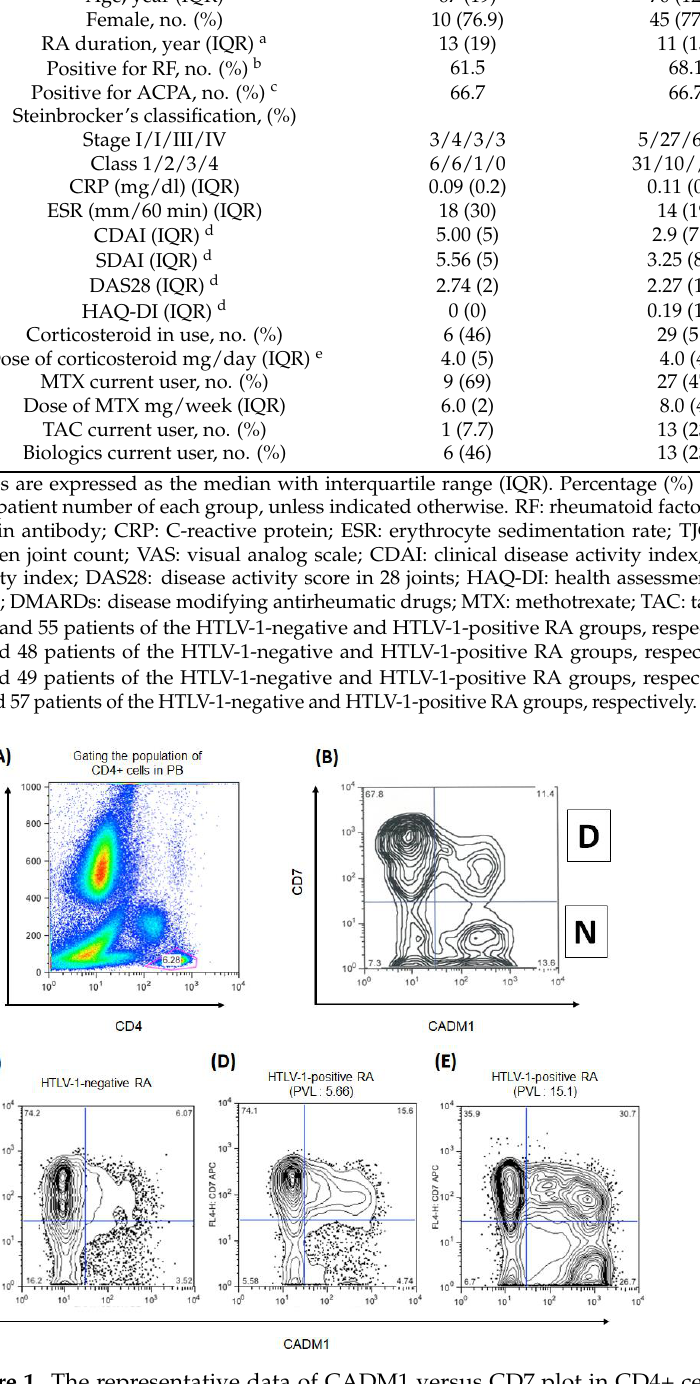
Figure 2. The comparison of CADM1+ CD4+ T-cell populations between human T-cell leukemia virus type 1 HTLV-1-negative and -positive participants with rheumatoid arthritis (RA). ( A ) The box plot of the population of CADM1+ CD4+ T-cells, which present in D + N region, in HTLV-1-